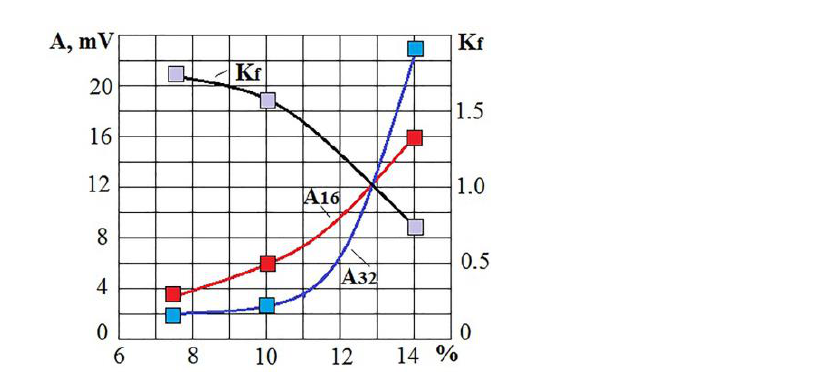
Figure 13. Dependence of the VA signal parameters on the discharge voltage (power density) when irradiating the M20 alloy. Thus, when electron beam processing, the behavior features of VA signal parame- ters noted during laser processing and mechanical machining (cutting) are preserved: an increase in the power density of the energy acting on the material to be processed leads to a deformation of the spectrum of the generated VA signal in the direction of a progres- sive increase in high-frequency components. 3. Comparison of Acoustic Properties of EDM and RBT Processes Electrical discharge machining technologies refer to technologies that affect the material to be processed by concentrated energy flows, similar to laser and electron beam processing. Thermal energy is transferred here by flows of electrons or ions. From the results obtained earlier for laser and electron beam processing, it can be concluded that VA signals will arise, and they will be the patterns of changes that should correspond to